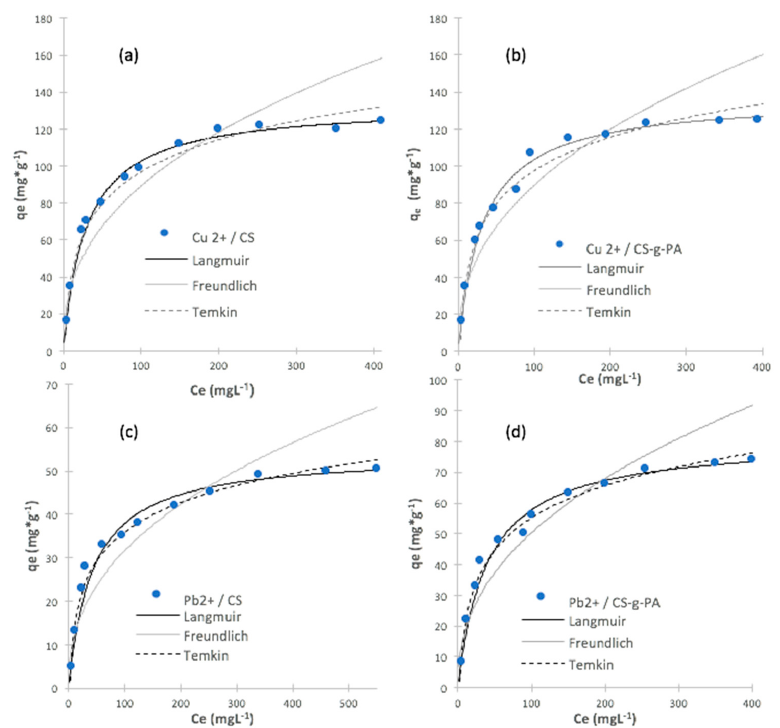
Figure 4. Non-linear theoretical model fitting for copper adsorption on ( a ) CS; ( b ) CS- g -TA; and theoretical model fitting for lead adsorption on ( c ) CS and ( d ) CS- g -TA. (pH: 4.0; adsorption time: 24 h; initial adsorbent quantity: 25 mg; initial volume: 50 mL; temperature: 25 °C).